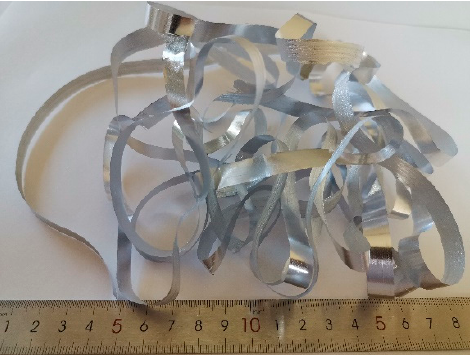
Figure 3. Foil-like brazing material fabricated by melt-spinning technology.